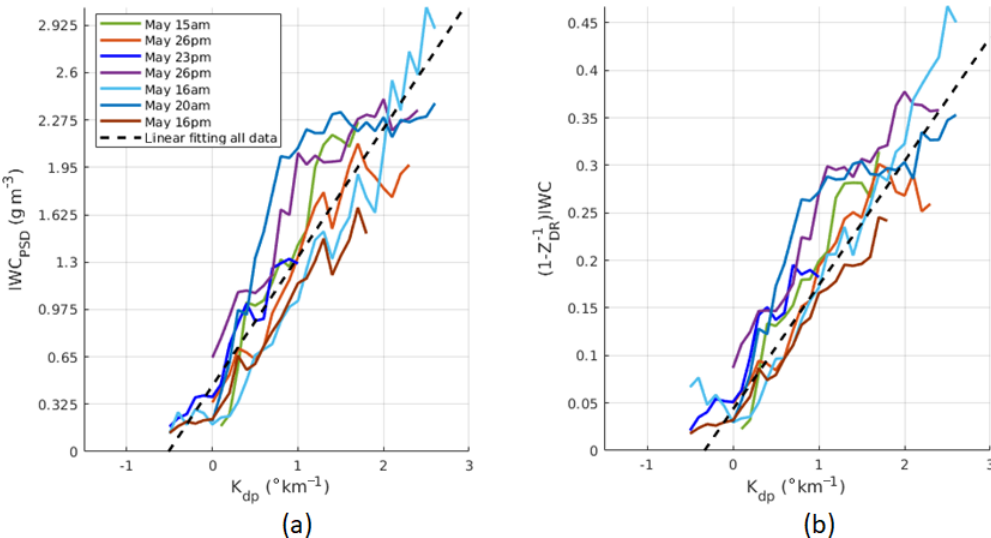
Figure 14. IWC PSD (a) and (1- Z − 1 )IWC (b) as functions of K dp for the seven selected flights. Linear fits (dash lines) are also plotted using DR coefficients computed from all data point (Table 2).